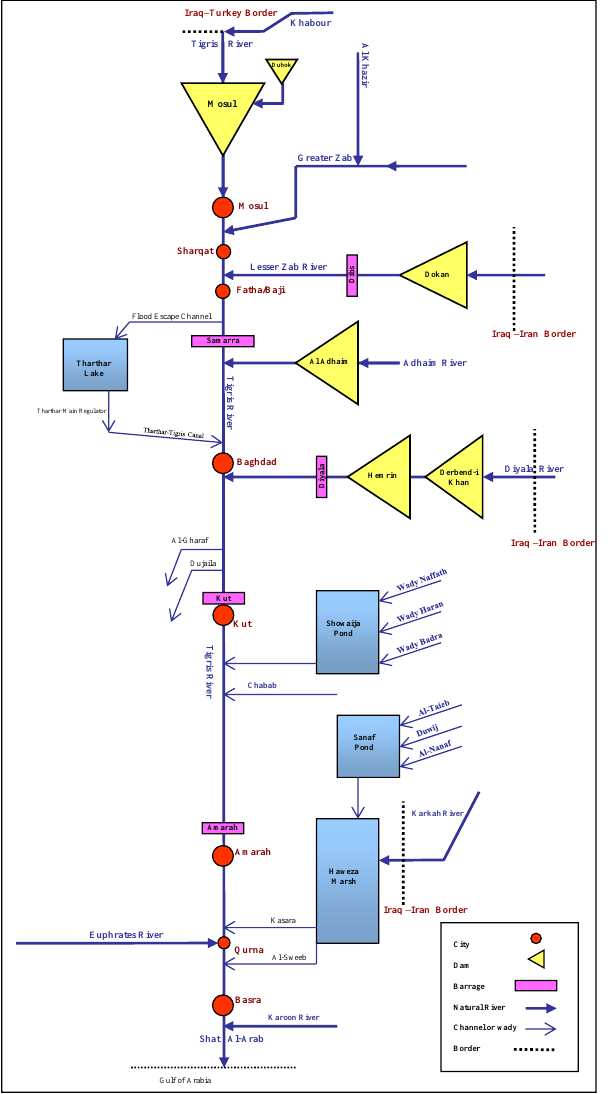
Figure 3. Schematic diagram of Tigris River and its tributaries hydrological scheme [12] Figure 3: Schematic diagram of Tigris River and its tributaries hydro- logical scheme [12]. Table 1: Catchment area of River Tigris.